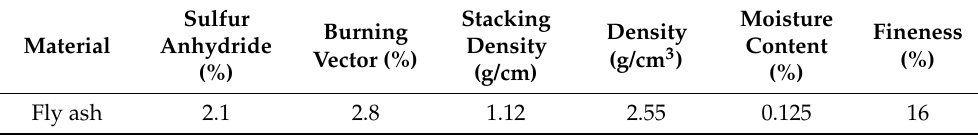
Table 3. Physical performance indices of fly Table 2. Performance indices of quartz sand.